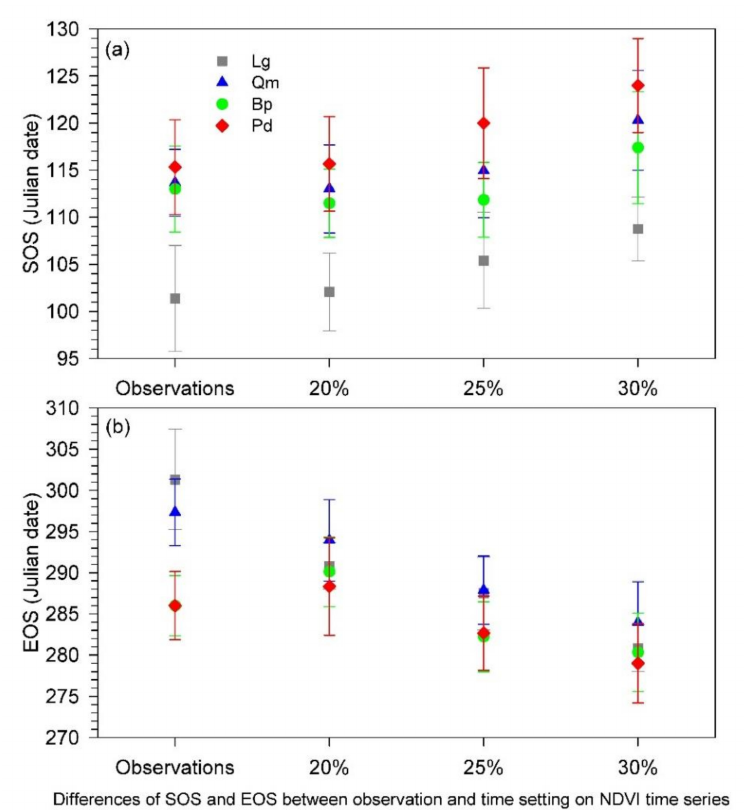
Figure 4. The di ff erences of the start of growing season (SOS) ( a ) and the end of growing season (EOS) ( b ) between observations and time setting on fitting curve of NDVI time series in TIMESAT. Four deciduous tree species in the study area include Larix gmelinii (Lg), Quercus mongolica (Qm), Betula platyphylla (Bp), and Populus davidiana (Pd), except for Pinus tabulaeformis (Pt) without in-situ